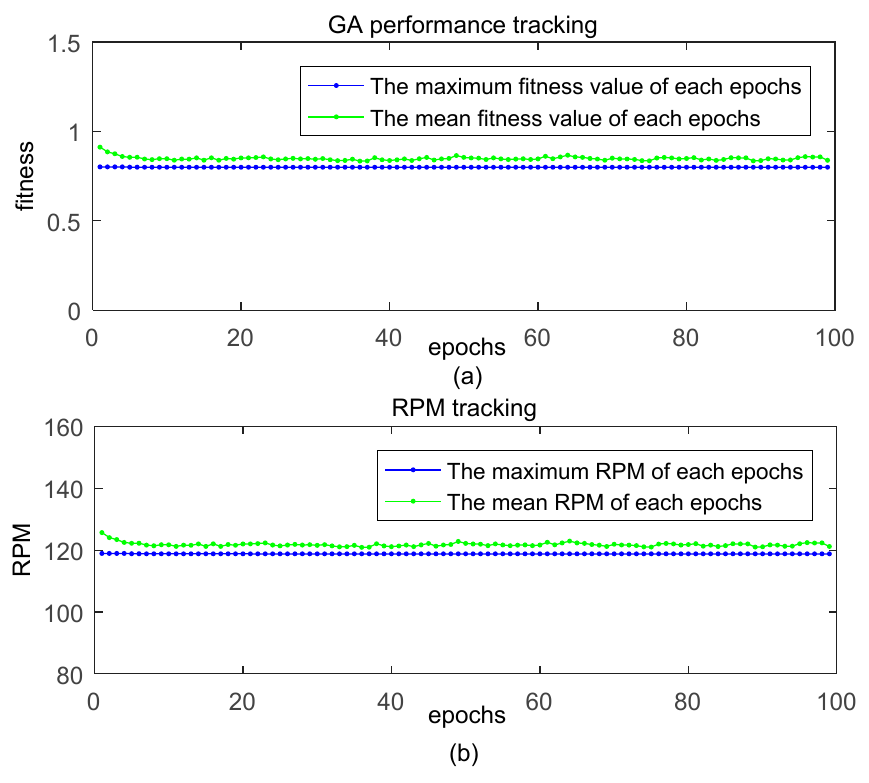
Figure 11. Performance tracking of the engine revolution optimization algorithm. ( a ) GA performance tracking ( b ) RPM tracking.